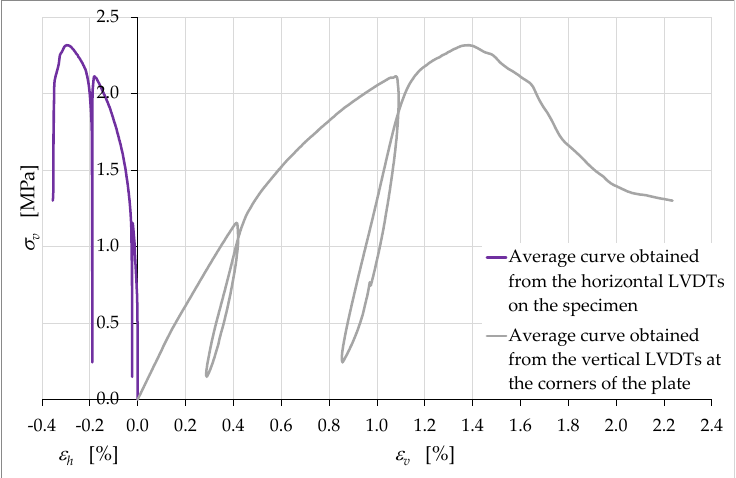
Figure 19. Average curves of axial stress with respect to axial and transverse strain.